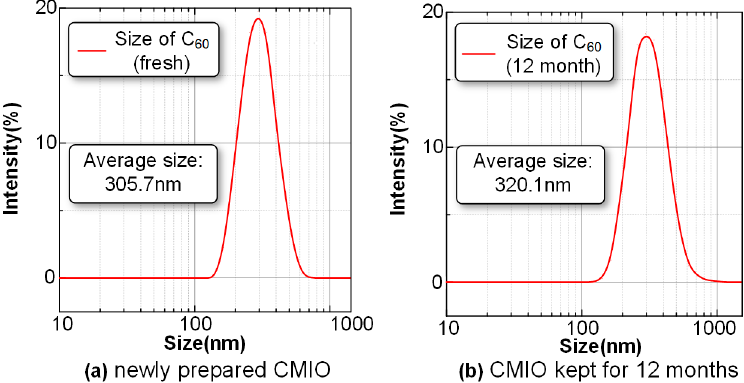
Figure 4. Particle size distribution of nano-C 60 particles in CMIO. ( a ) newly prepared CMIO, ( b ) CMIO kept for 12 months. (Please note that whether a particle larger than 100 nm can be called a